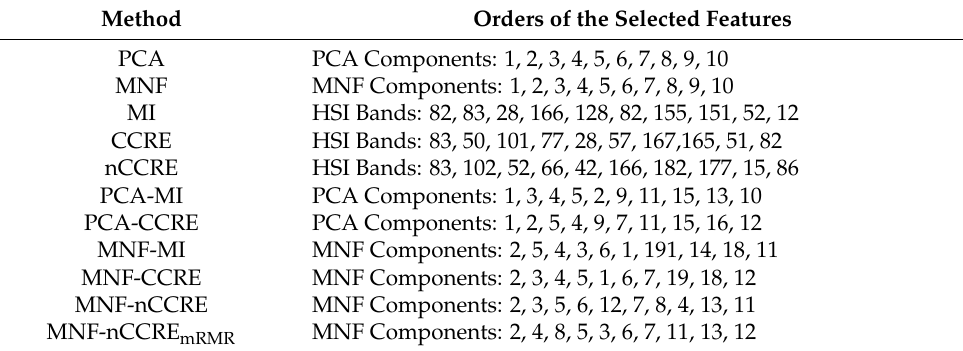
Table 4. The order of selected features for HYDICE WDM dataset. Method